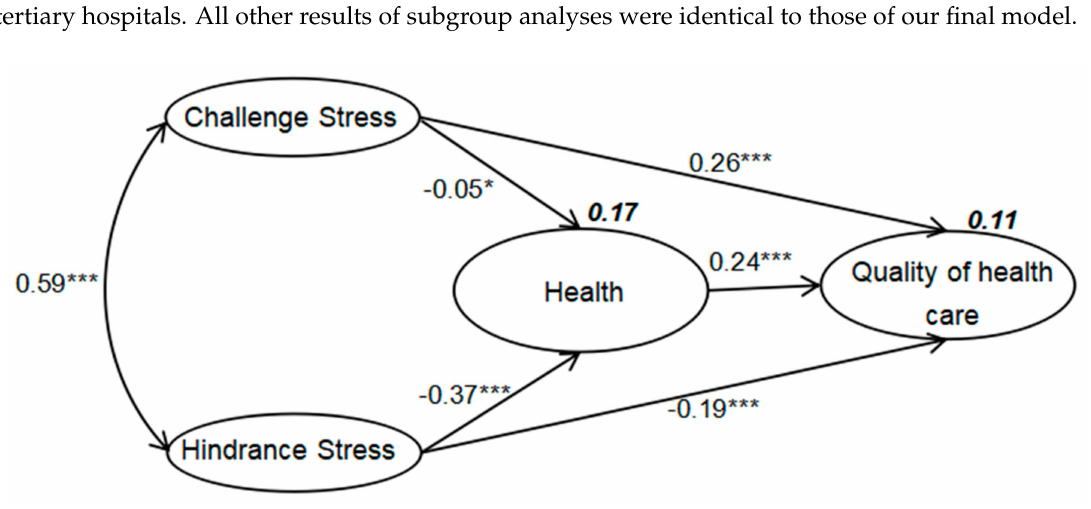
Figure 2. Final structural equation model, with standardized maximum likelihood estimates (Chi square, 1894.033; p = 0.000; root mean square error of approximation, 0.060; goodness-of-fit index, 0.931; normed fit index, 0.945; comparative fit index, 0.951; *** p < 0.001; * p <